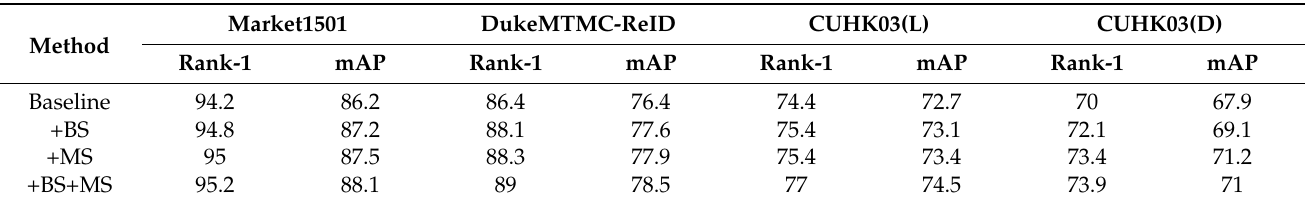
Table 2. Influences of self-erasing network on three